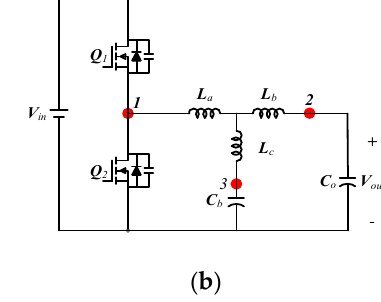
Figure 4. Structure diagram of the equivalent fourth-order LCLC filter of the RCCC circuit. Using the same method, the coupled inductor in LL-LC is converted to a T-type model, as shown in Figure 5.